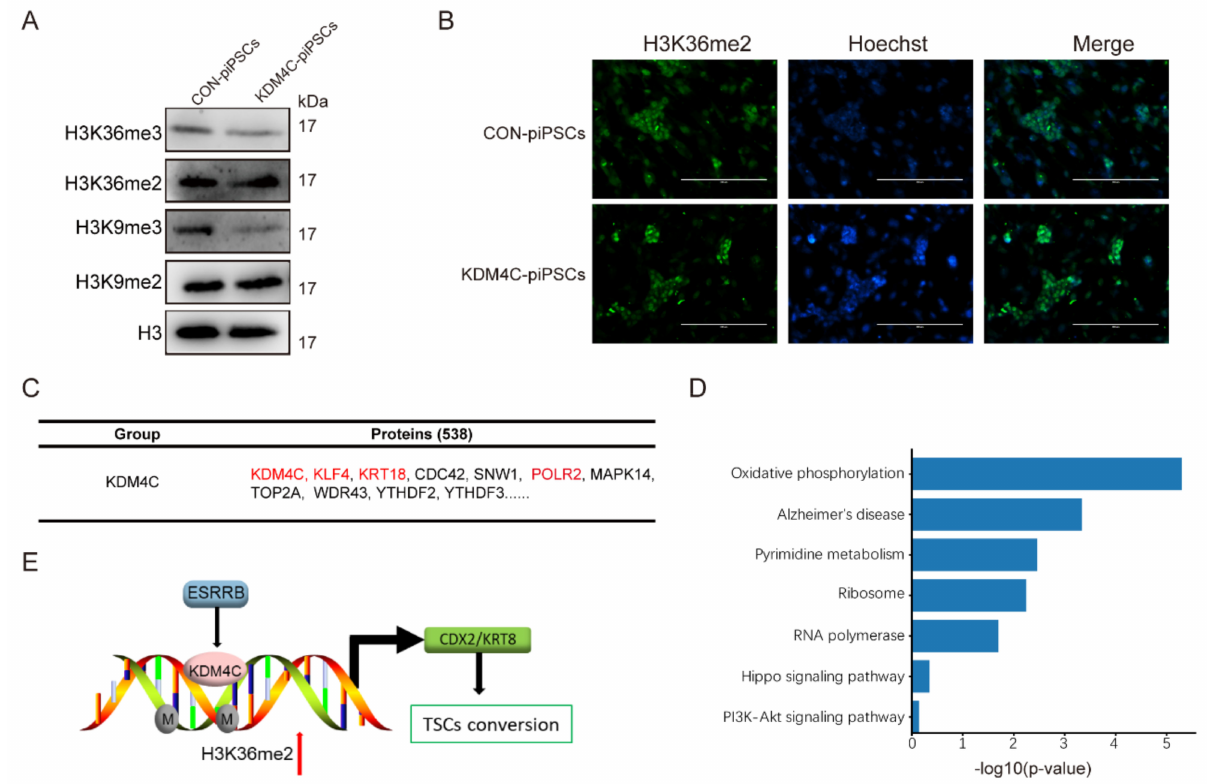
Figure 5. The expression levels of H3K36me1/2/3 in CON − and KDM4C − piPSCs. ( A ) Western blot analysis of H3K36me2/3 and H3K9me2/3 in CON- and KDM4C-piPSCs; ( B ) the immunofluorescence staining of H3K36me2 in CON- and KDM4C-piPSCs; the scale bar represents 400 µ m. ( C ) The table lists FLAG-enriched KDM4C-associated proteins in KDM4C-piPSCs detected by immunoprecipitates– MS analysis; the CON-piPSCs was used as a control. ( D ) The KEGG enrichment in KDM4C-associated proteins in KDM4C-piPSCs; ( E ) model for action of ESRRB, KDM4C and CDX2 during pluripotency conversion into